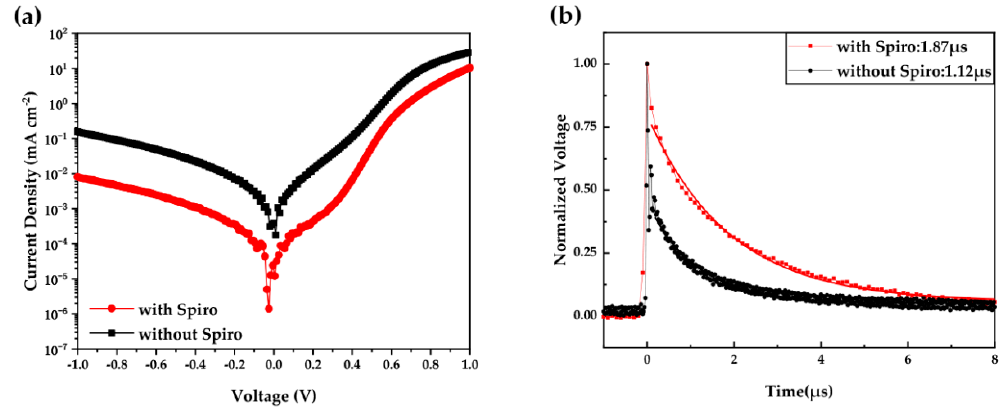
Figure 7. ( a ) J–V curves under dark and ( b ) transient photovoltage (TPV) measurements of the champion and control devices.